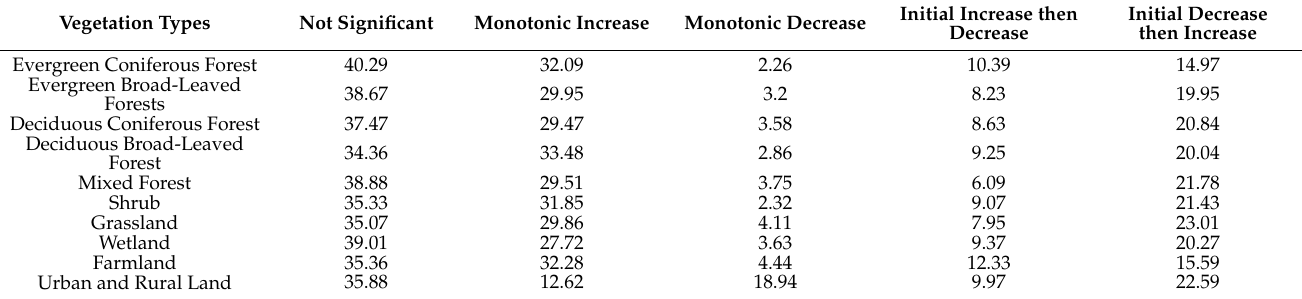
Table 7. Area percentage (%) of the nonlinear trend classification under different vegetation